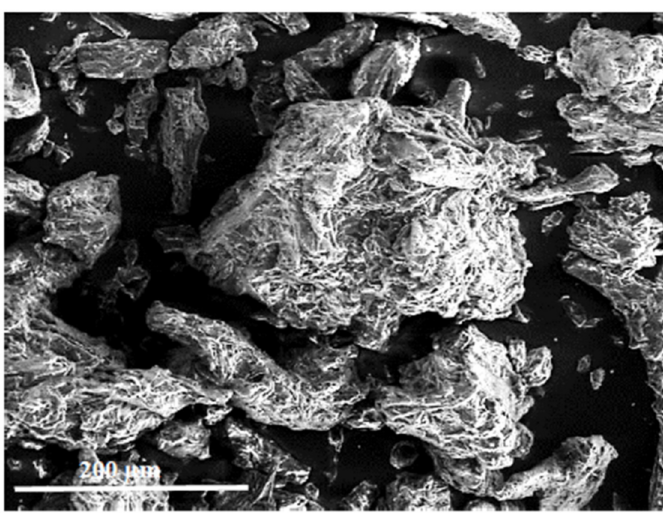
Figure 11. Flax fibers (own research).